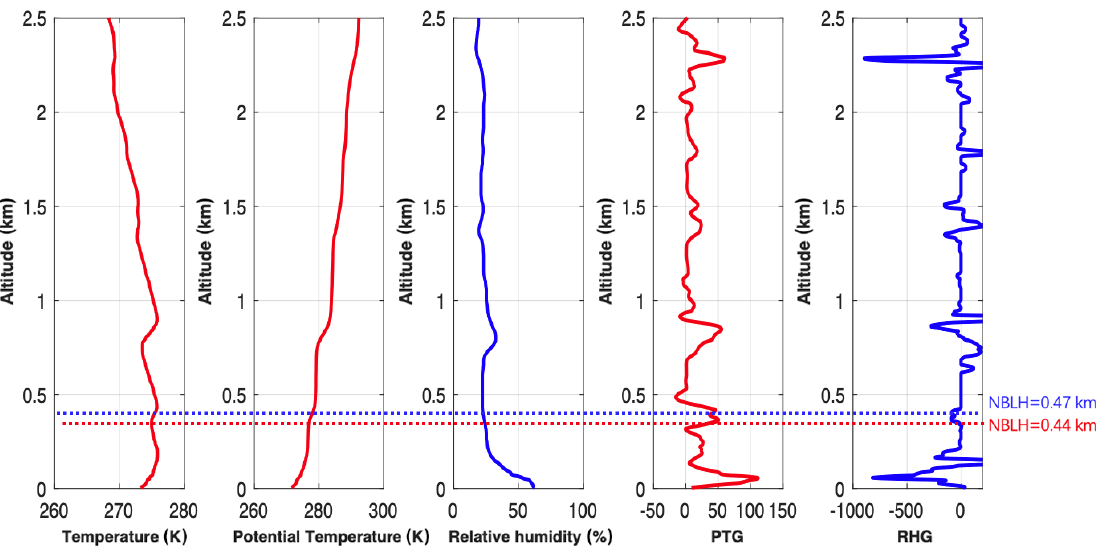
Figure 14. Planetary boundary layer height estimates using radiosondes. Profiles include temperature, potential temperature, relative humid- ity, potential temperature gradient (PTG), and relative humidity gradient (RHG). Estimated NBLH by PTG (red) and RHG (blue) are shown by dashed horizontal lines at